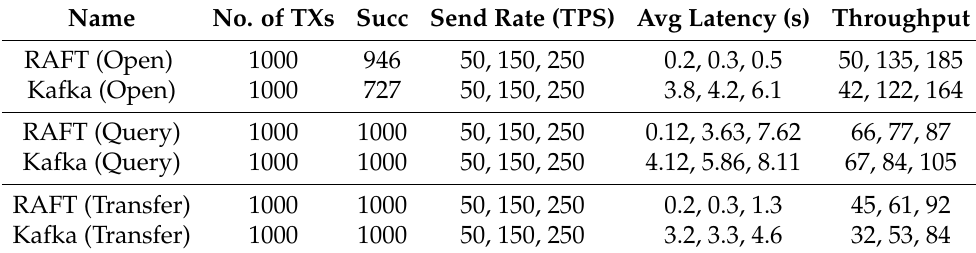
Table 3. Efficacy of the proposed multi-host, RAFT framework with 1000 transactions.